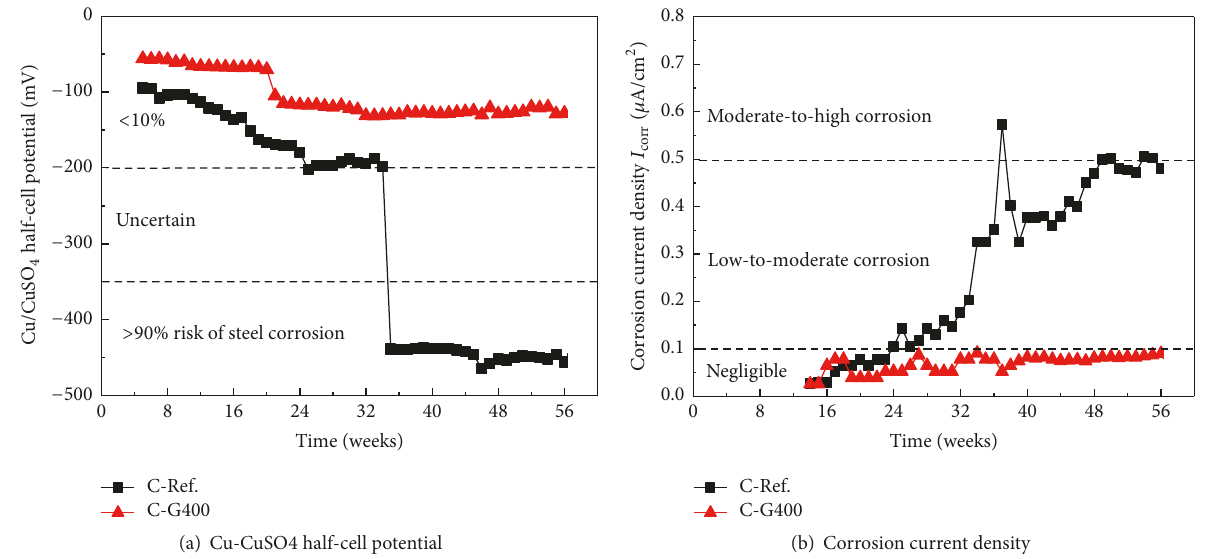
Figure 12: Cu-CuSO 4 half-cell potential (a) and corrosion current density (b) of reinforced steel in reference untreated and surface impregnated concrete by